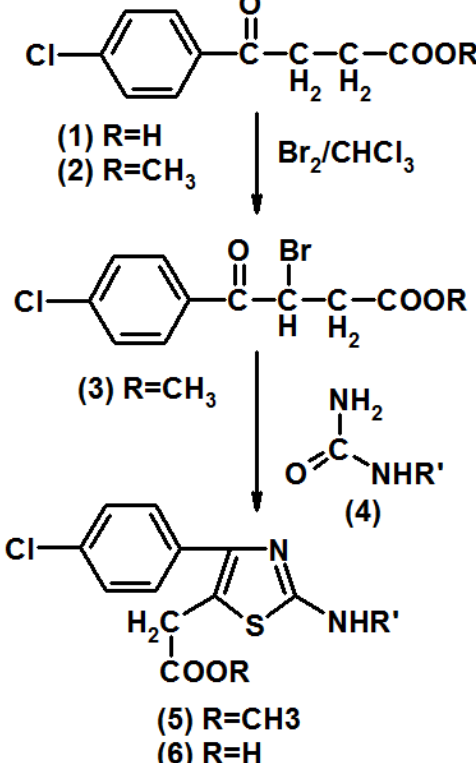
Scheme 1. Scheme of the synthesis of the derivatives of